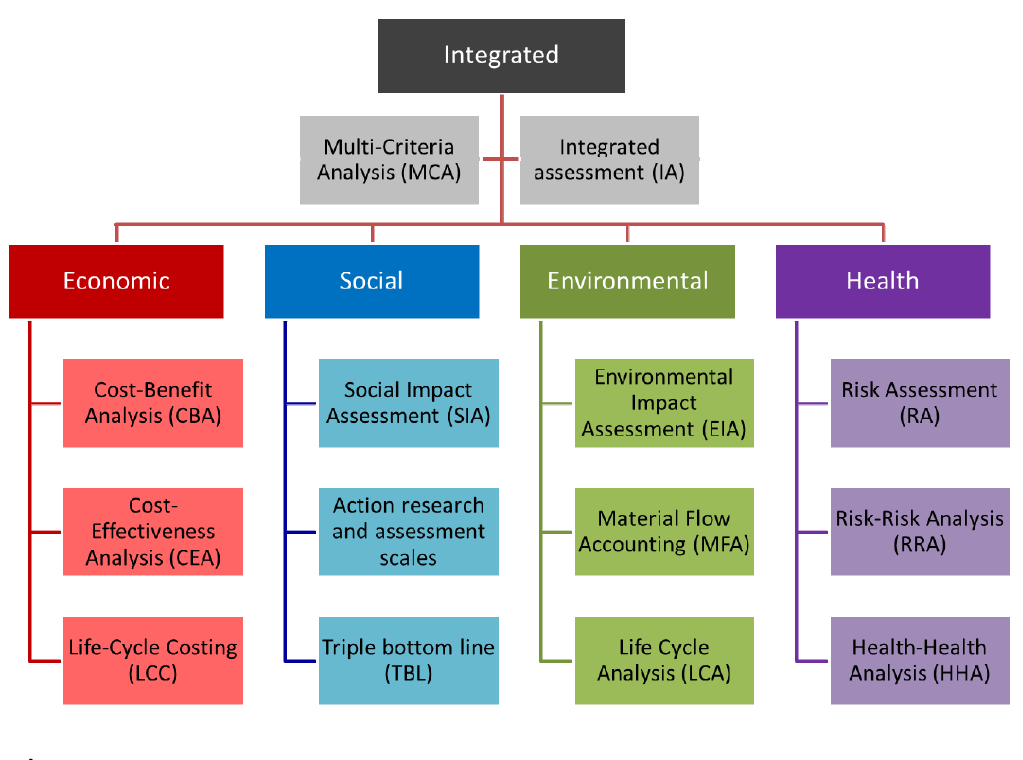
Figure 2. Classification of commonly used decision-aid tools in sustainable drainage assessment